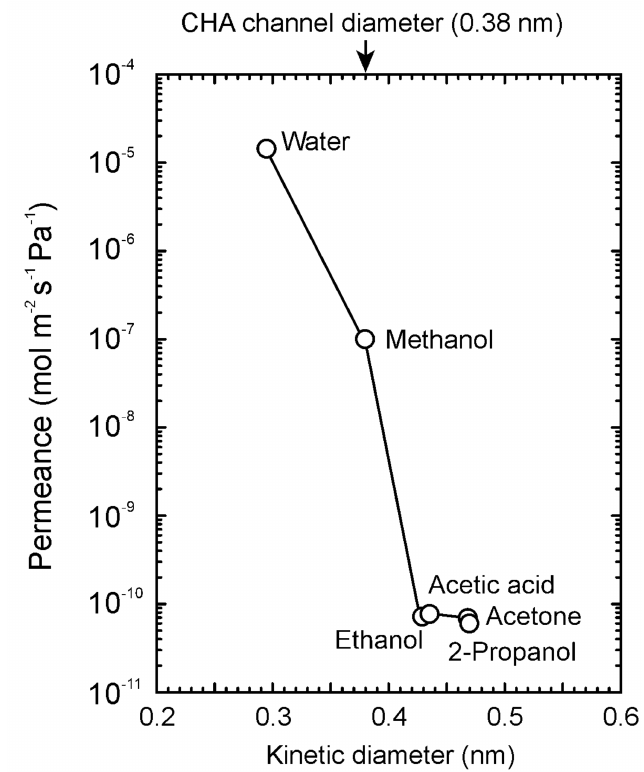
Figure 5. Influence of the molecular size on the permeances of single component solvents at 303 K.